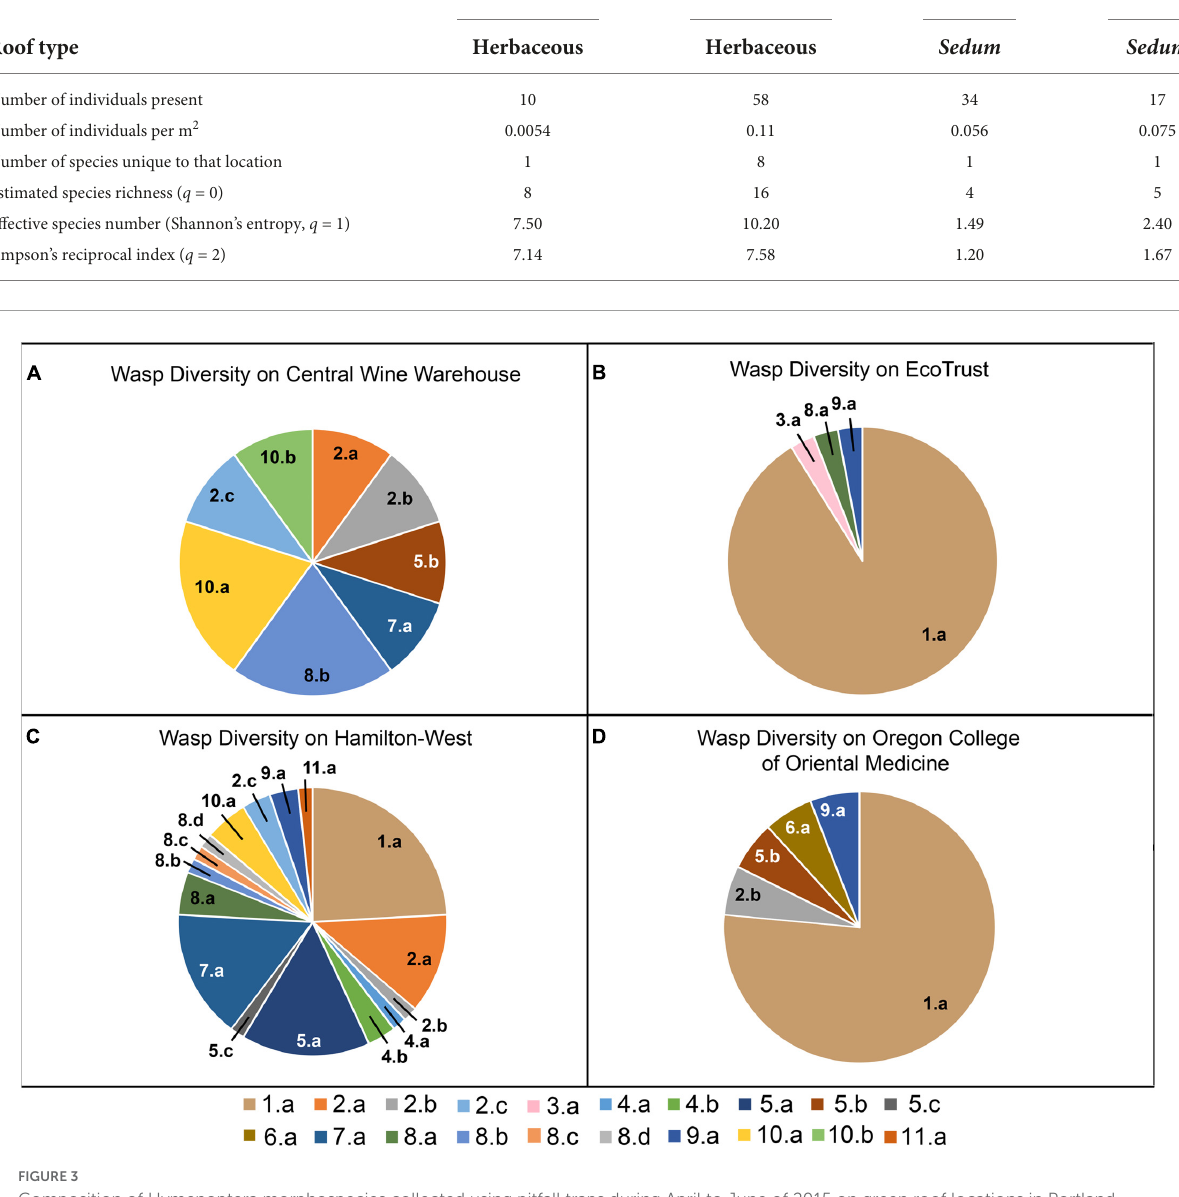
TABLE 3 Abundance and diversity metrics for parasitoid wasp communities present on four green roofs (CWW, Central Wine Warehouse; ET, EcoTrust; HW, Hamilton West; OCOM, Oregon College of Oriental Medicine) within Portland, Oregon. CWW HW ET OCOM